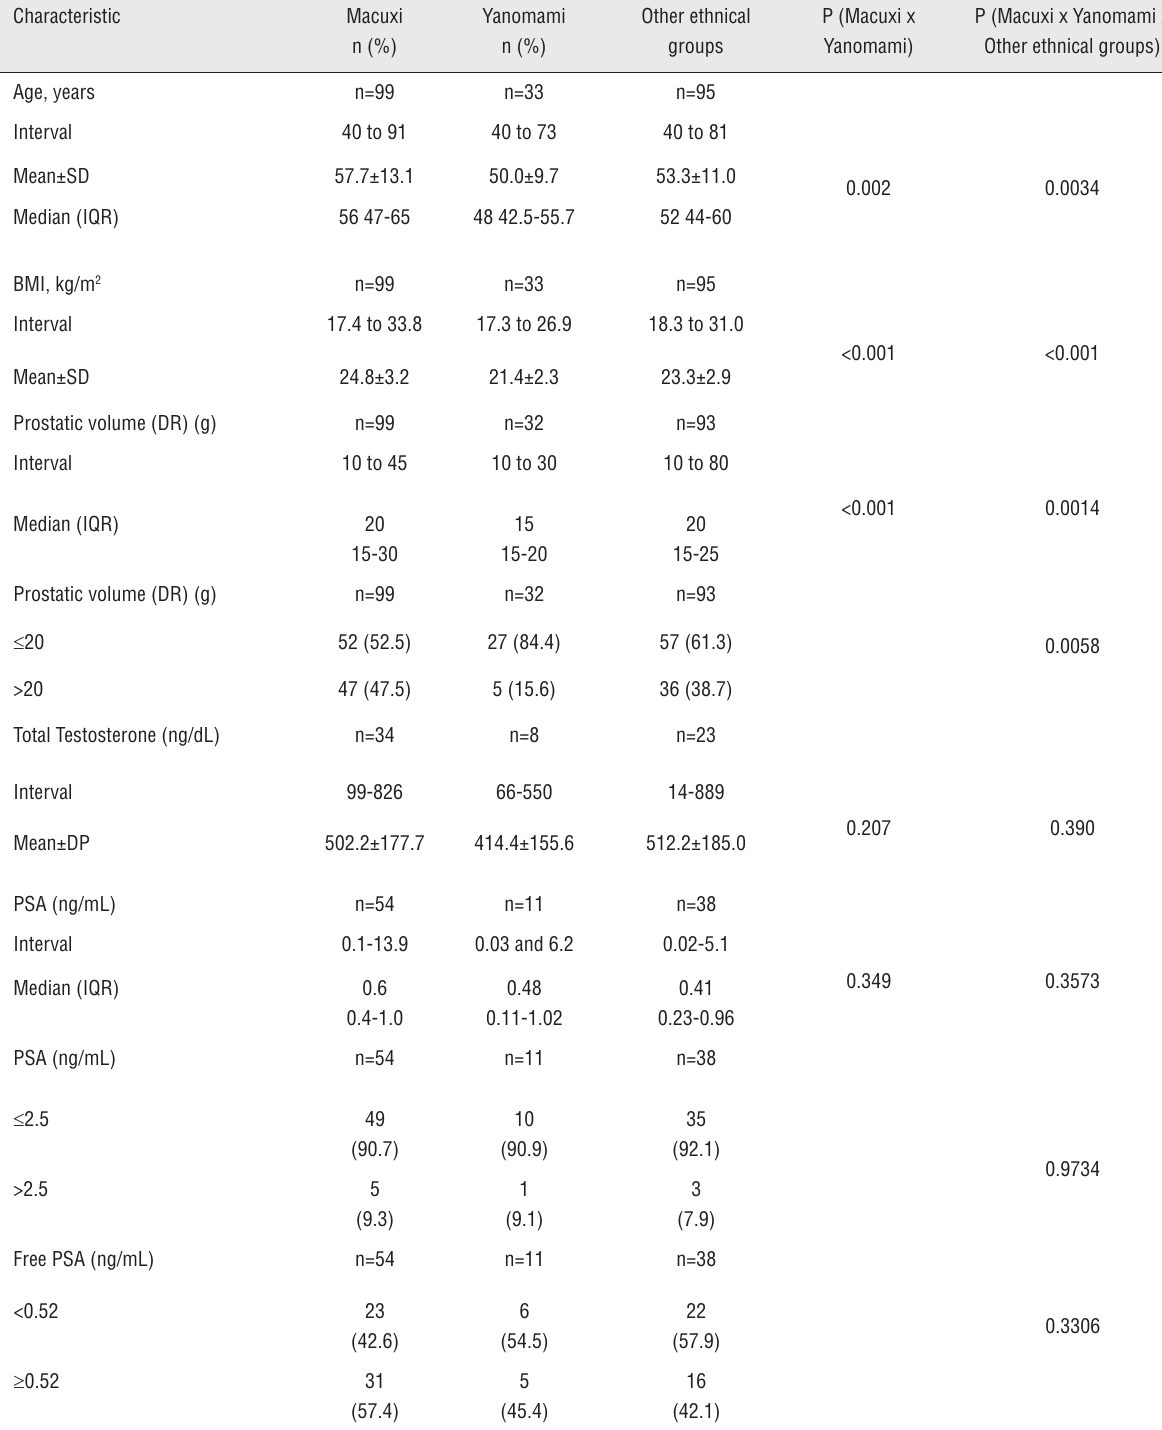
Table 3 - Demographic and clinical characteristic of Macuxis, Yanomamis and “others ethnical groups”.